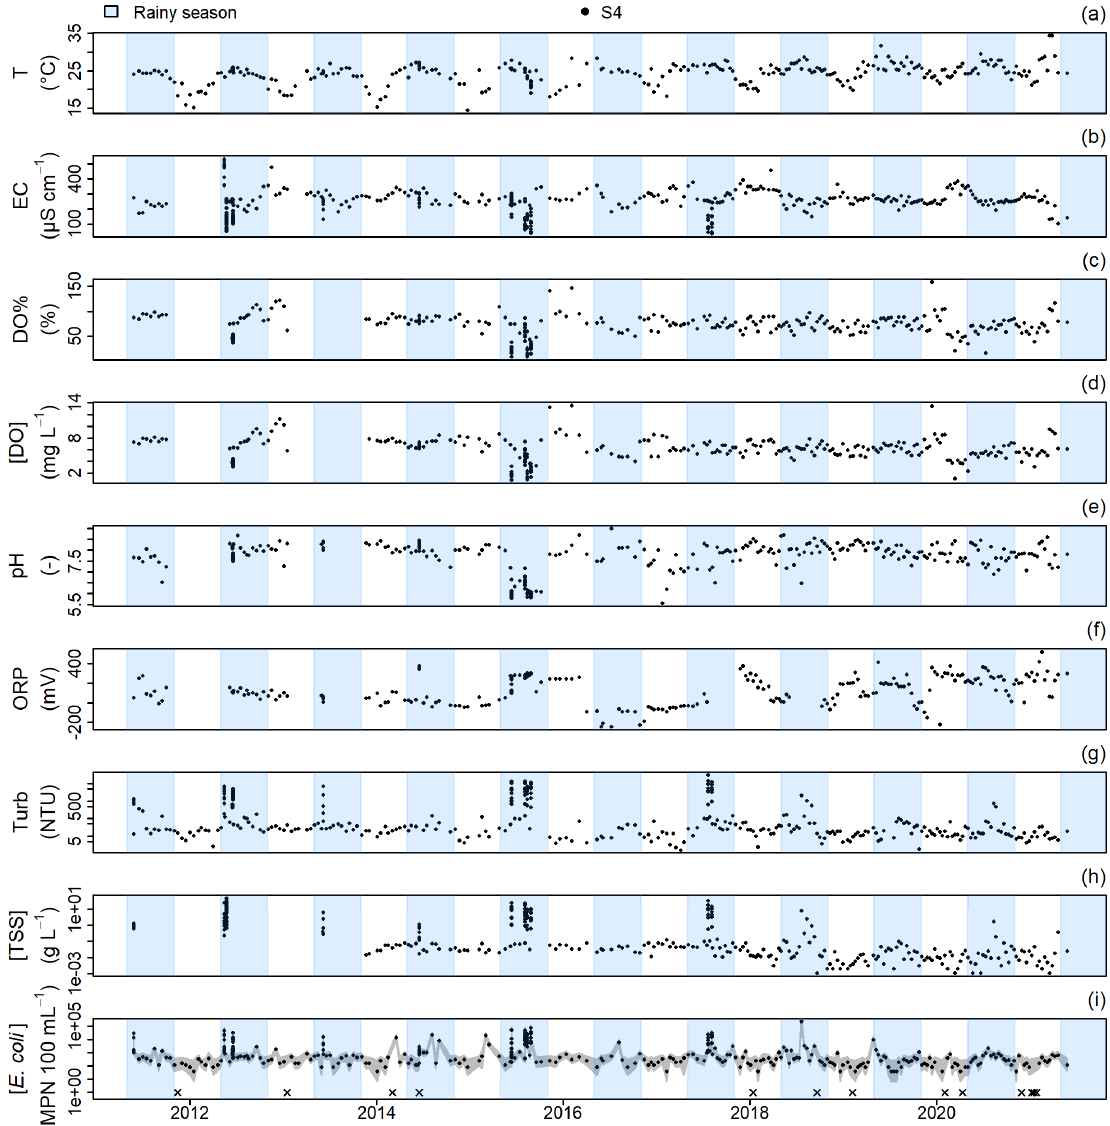
Figure 5. Stream water quality from 2011 to 2021 at the outlet of the Houay Pano catchment (sampling station S4), northern Lao PDR. T : temperature ( ◦ C); EC: electrical conductance at 25 ◦ C (µScm − 1 ); DO%: oxygen saturation (%); [DO]: oxygen concentration (mgL − 1 ); pH: pH (–); ORP: oxidation-reduction potential (mV); Turb: turbidity (NTU); [TSS]: total suspended sediment concentration (gL − 1 ); [ E. coli ]: Escherichia coli concentration (MPN 100mL − 1 ) with lower and upper limits of the confidence interval given by Poisson distribution using the standardized microplate method. Turb, [TSS], and [ E. coli ] are shown with y axis as log scale. We added 0.0001 and 1 to all [TSS] and [ E. coli ] values, respectively, to present 0 values in a log scale, by convention. Crosses for [ E. coli ] represent [ E. coli ] below the detection limit. Blue polygons represent the rainy season from May to